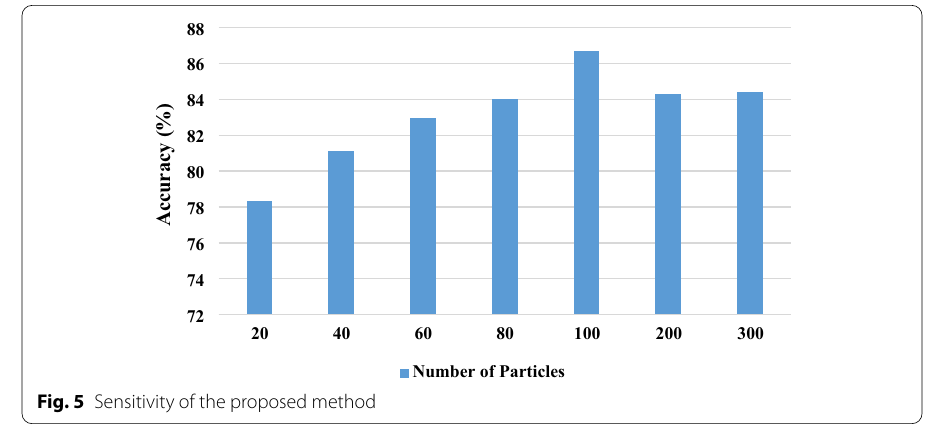
Fig. 5 Sensitivity of the proposed method